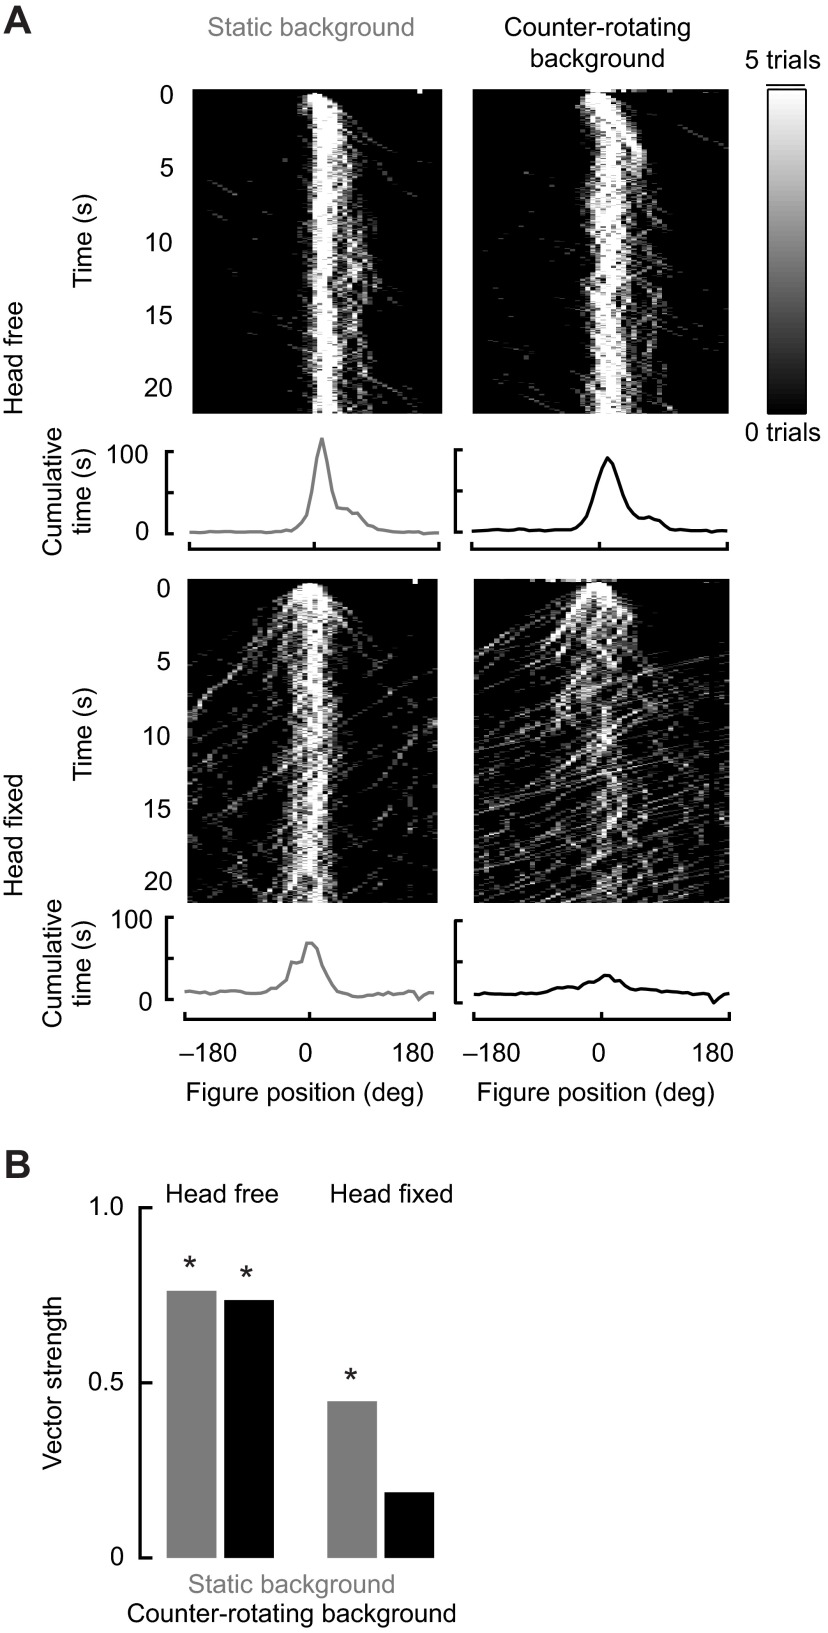
Figure tracking under closed-loop control with and without head movements. In these experiments, flies were able to control the position of the figure stimulus by steering their wings. (A) Traces of figure position during all closed-loop trials. Top row: traces for head-free flies (N=11 flies, 55 trials); bottom row: traces for head-fixed flies (N=12 flies, 60 trials). Left: moving figure on static wide-field panorama; right: moving figure on counter-rotating wide-field panorama. Graphs underneath each set of traces represent the position of the bar during the last 15 s of each trial. (B) Vector strength measurements for the last 10 s of each trial. Asterisks indicate where flies are fixating the figure, as determined by a Rayleigh z-test (*P<0.05). Head-free flies are able to fixate the figure regardless of wide-field motion; head-fixed flies are able to fixate the figure on a static wide-field panorama, but not a counter-rotating wide-field panorama.